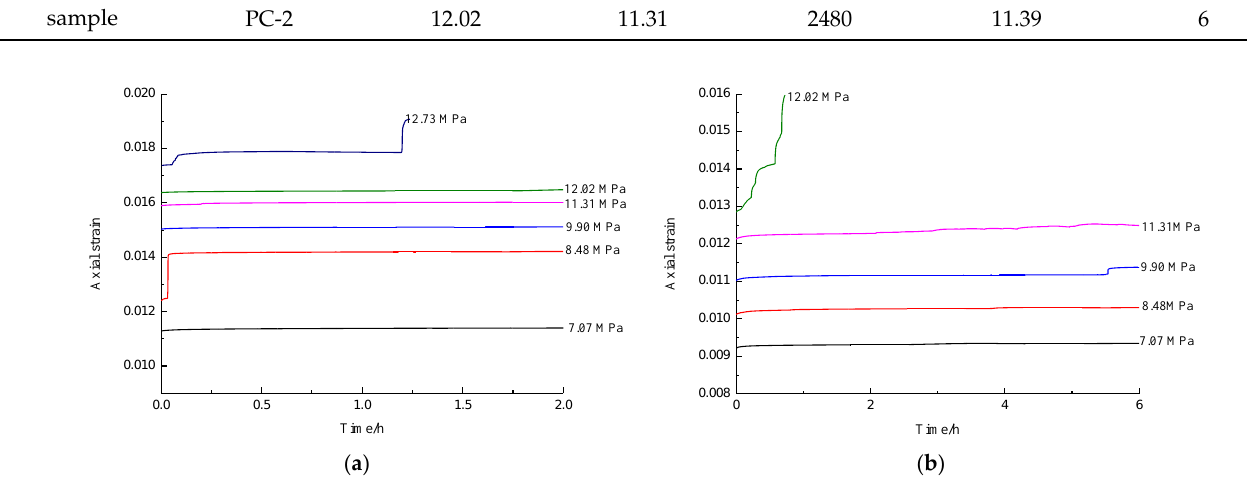
Figure 8. Creep curves of pure coal samples: ( a ) Creep curve of PC-1 pure coal sample; ( b ) Creep curve of PC-2 pure coal sample.